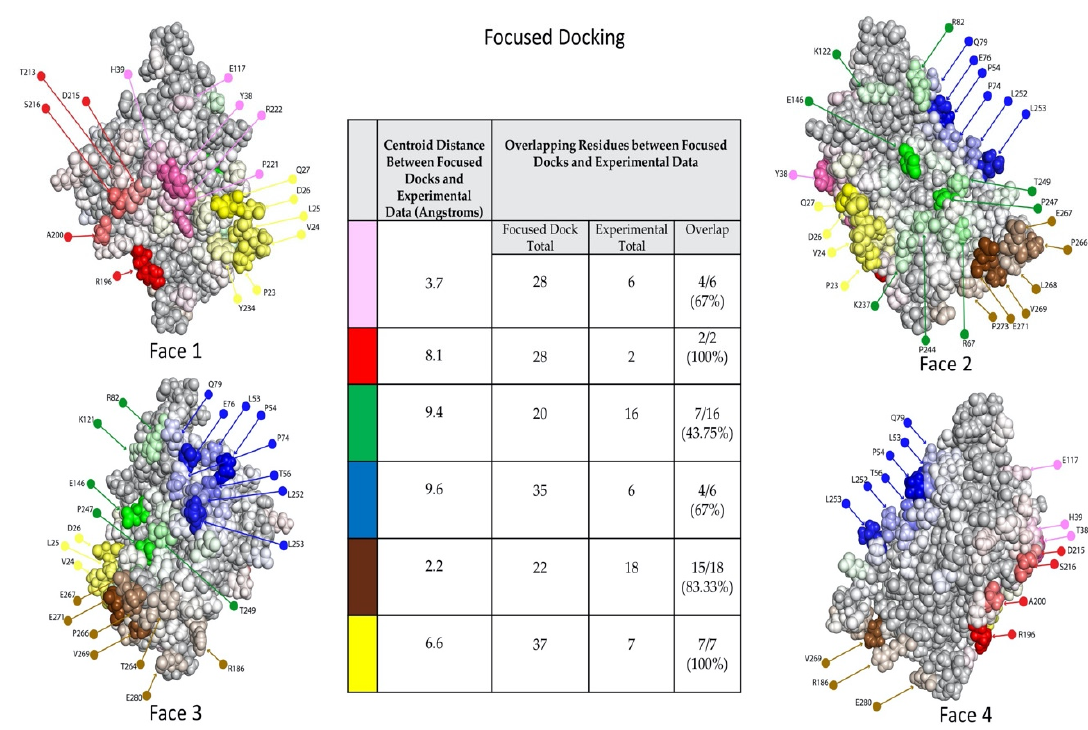
Figure 9. Community map of experimentally-focused docking models for Abs vs. gD2. The same representation as Figure 5, but based on docking models that were focused according to experimental data. Note the relative homogeneity of Abs (different symbols) within each community, contrasting with Figure 5. The shape of each marker indicates the antibody in the dock (i.e., each shape is a single antibody).